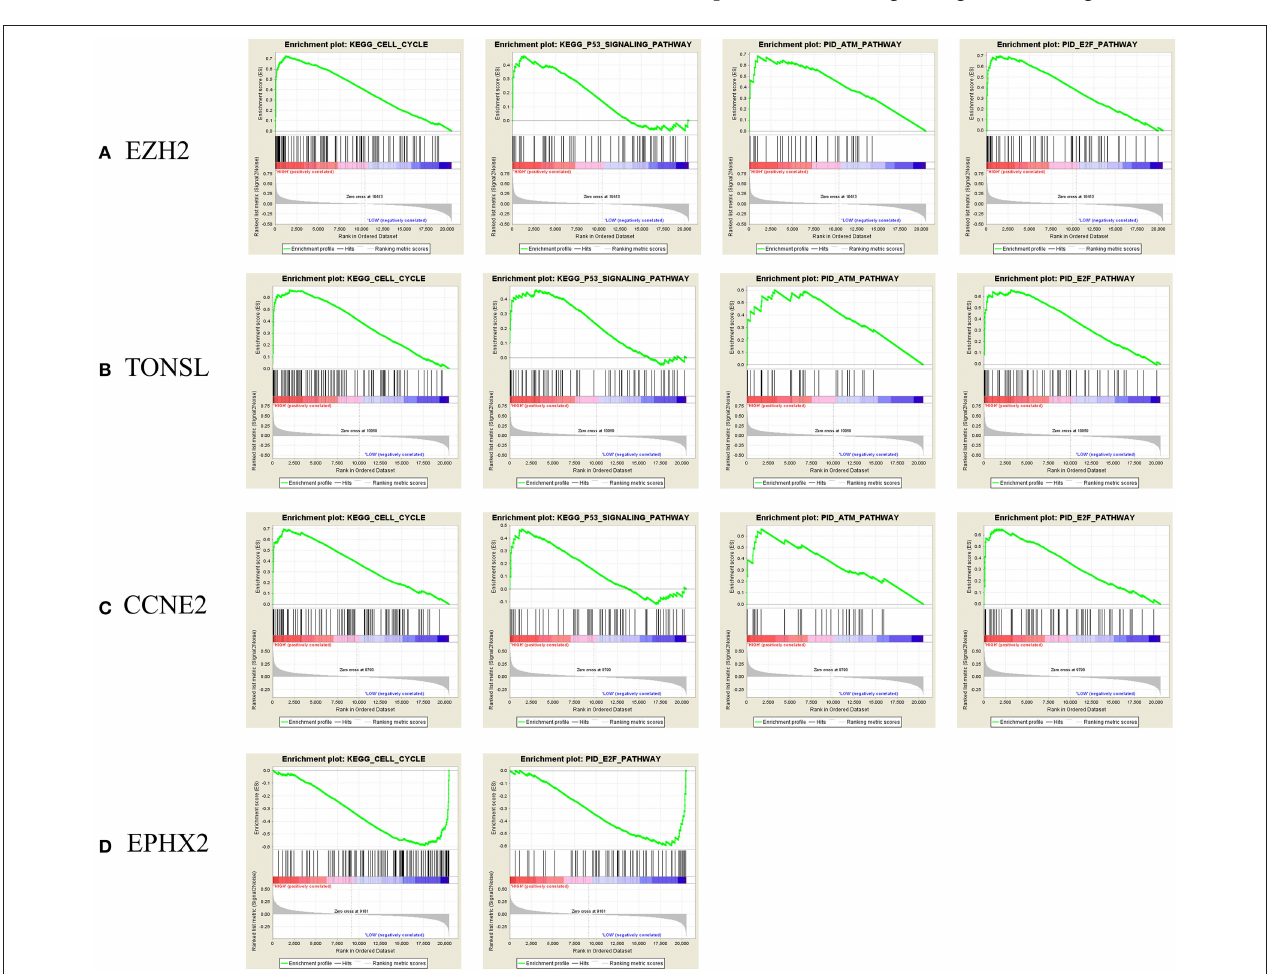
FIGURE 7 | Gene Set Enrichment Analysis (GSEA) curve. (A) E2H2 , (B) TONEL , (C) CCNE2 , and (D) EPHX-2 . KEGG, Kyoto Encyclopedia of Genes and Genomes. ATM, ataxia telangiectasia-mutated.